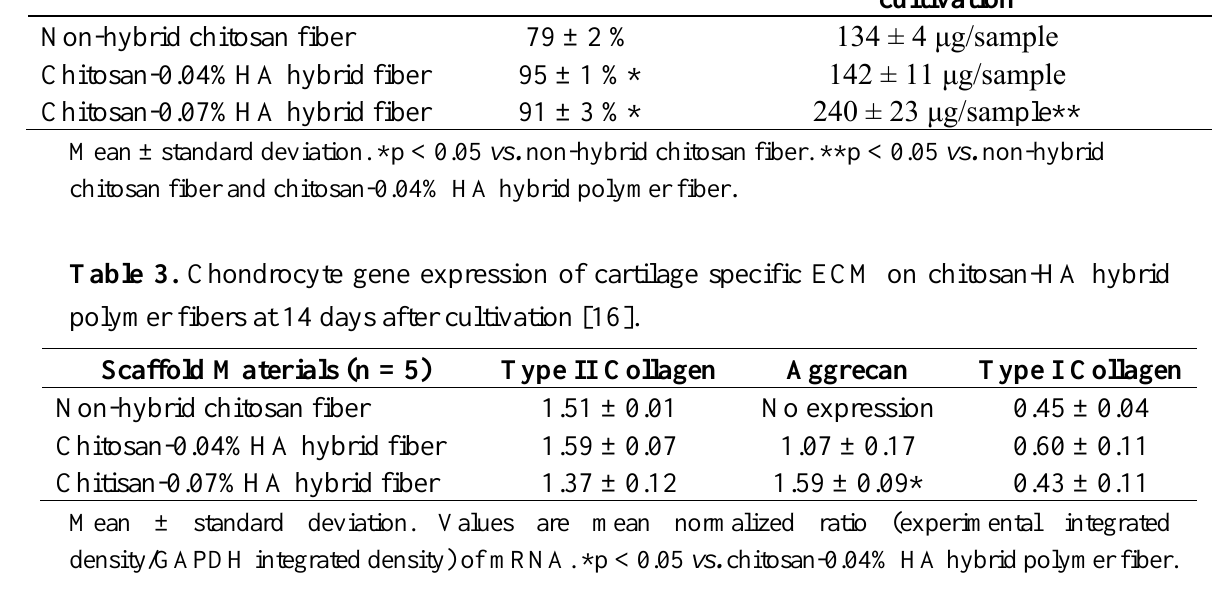
Table 2. Chondrocyte adhesion and DNA content on chitosan-HA hybrid polymer fibers [16]. Scaffold Materials (n = 5)